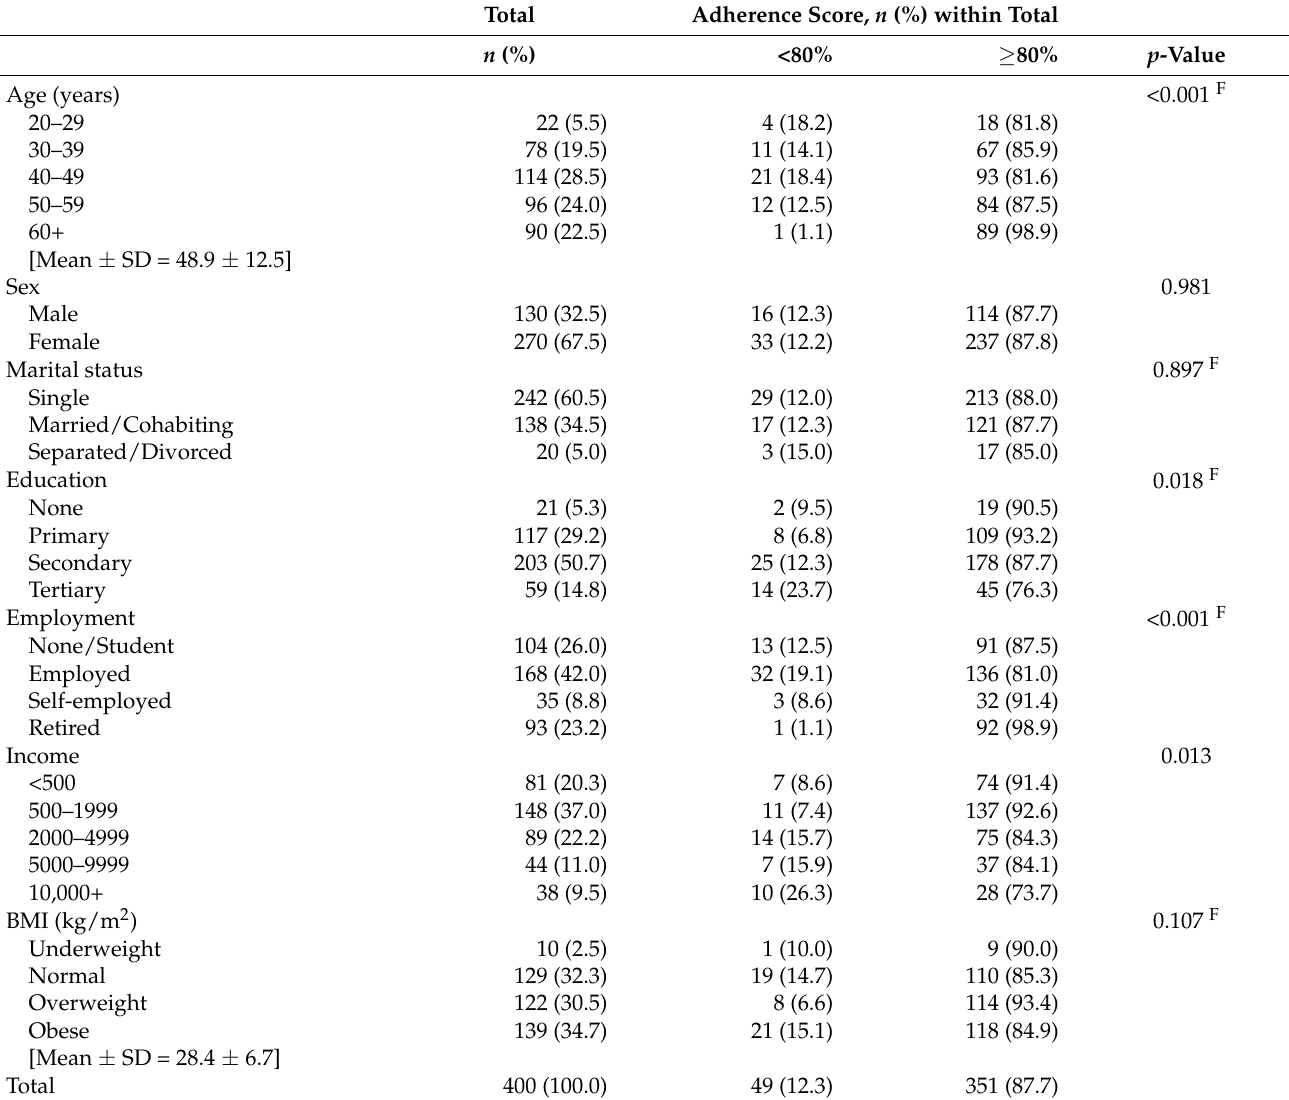
Table 2. Bivariate analysis of characteristics of respondents and adherence.